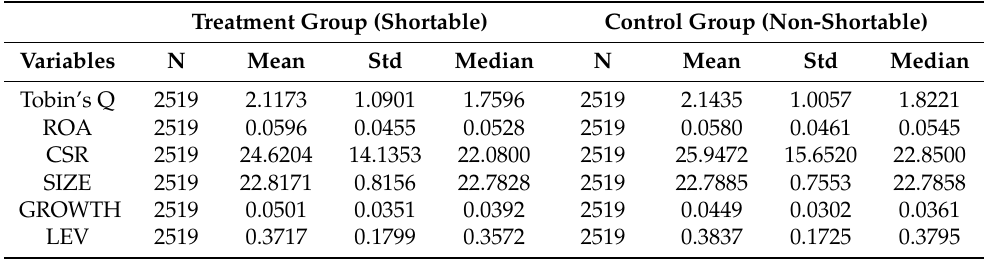
Table 2. Statistics of the samples after the propensity score matching (PSM)